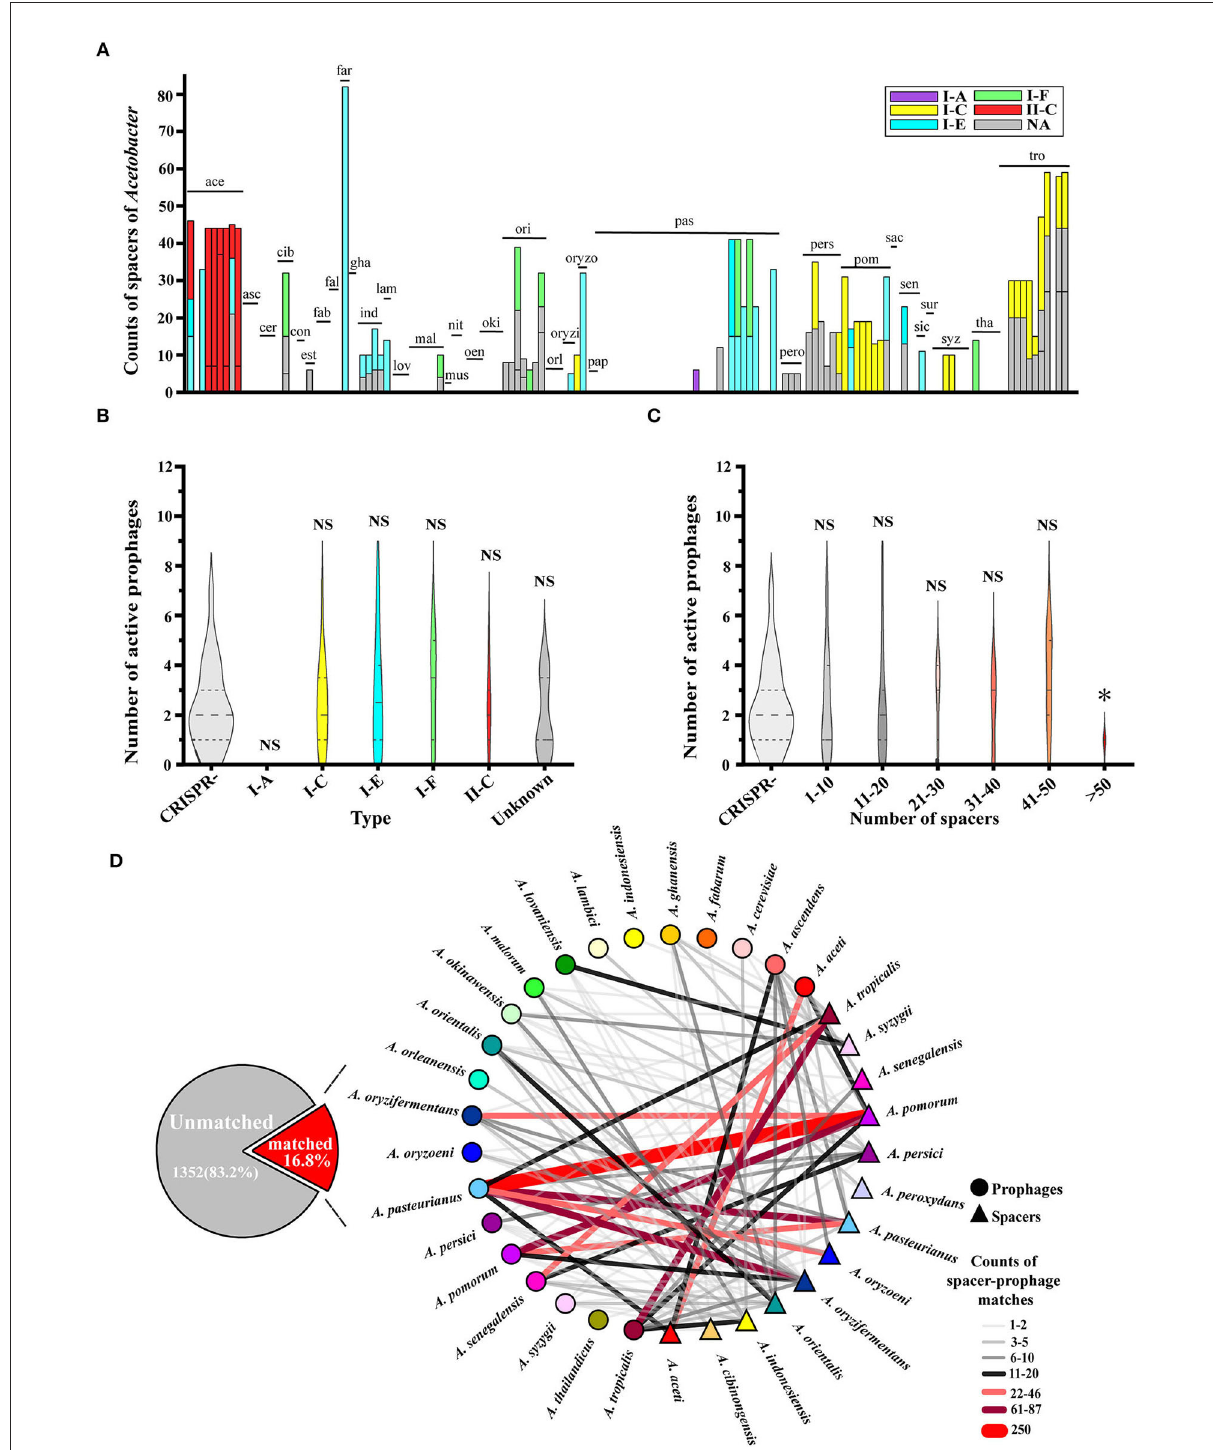
FIGURE5 Analysis of CRISPR-Cas system spacers on the Acetobacter genome sequences. (A) The number of CRISPR-Cas system spacers counted for each Acetobacter species, and different colors represent different types of CRISPR-Cas systems. Purple I-A, yellow I-C, blue I-E, green I-F, red II-C, and black NA. (B) Relationship between CRISPR-Cas system types and prophage numbers. (C) Relationship between the genomic CRISPR-Cas system spacers and the number of prophages in Acetobacter . X-axis is the total number of CRISPR-Cas system spacers, and Y-axis is the number of prophages. Non-parametric Mann–Whitney U-test and two-tailed method were used to calculate p- values. (D) Spacer-prophage matching